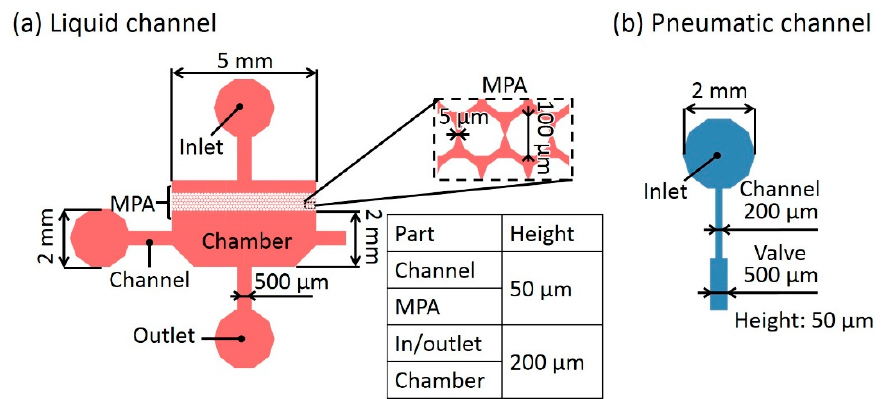
Figure 4. Dimensions of the microfluidic device. ( a ) Liquid channel. ( b ) Pneumatic channel.